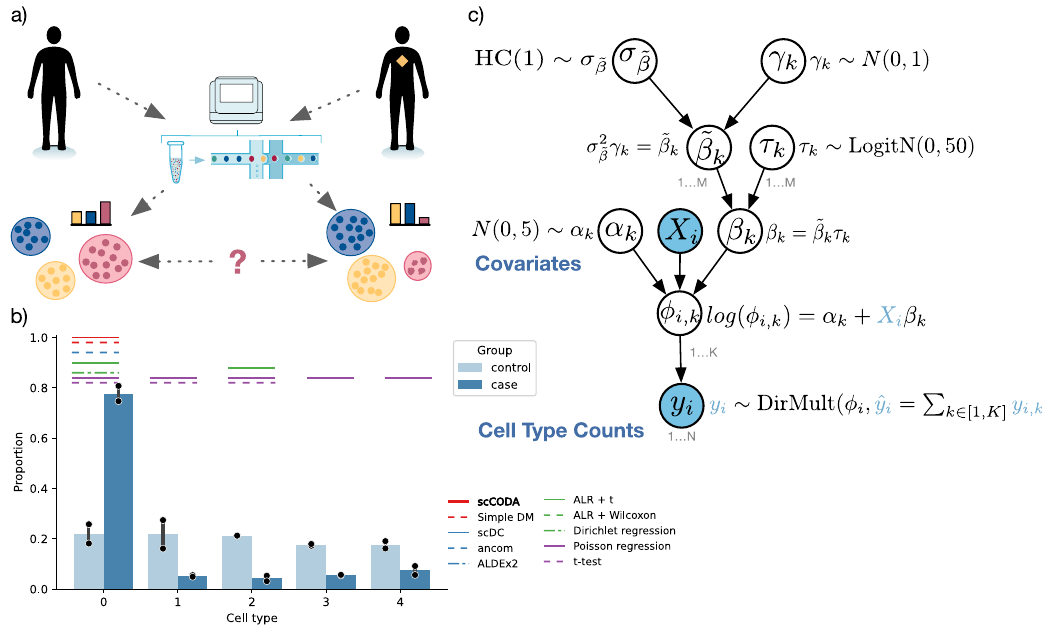
Fig. 1 Compositional data analysis in single-cell RNA-sequencing data. a Single-cell analysis of control and disease states of a human tissue sample. Disease states re fl ect changes in the cell-type composition. b Exemplary realization of the tested scenarios with high compositional log-fold change and low replicate number ( n = 2 samples per group). Colored horizontal lines indicate statistically detected compositional changes between case and control for different methods. The error bars denote the 95% con fi dence interval around the mean. c The scCODA model structure with hyperparameters. Blue variables are observed. DirMult indicates a Dirichlet-Multinomial, N a Normal, logitN a Logit-Normal, and HC a Half-Cauchy